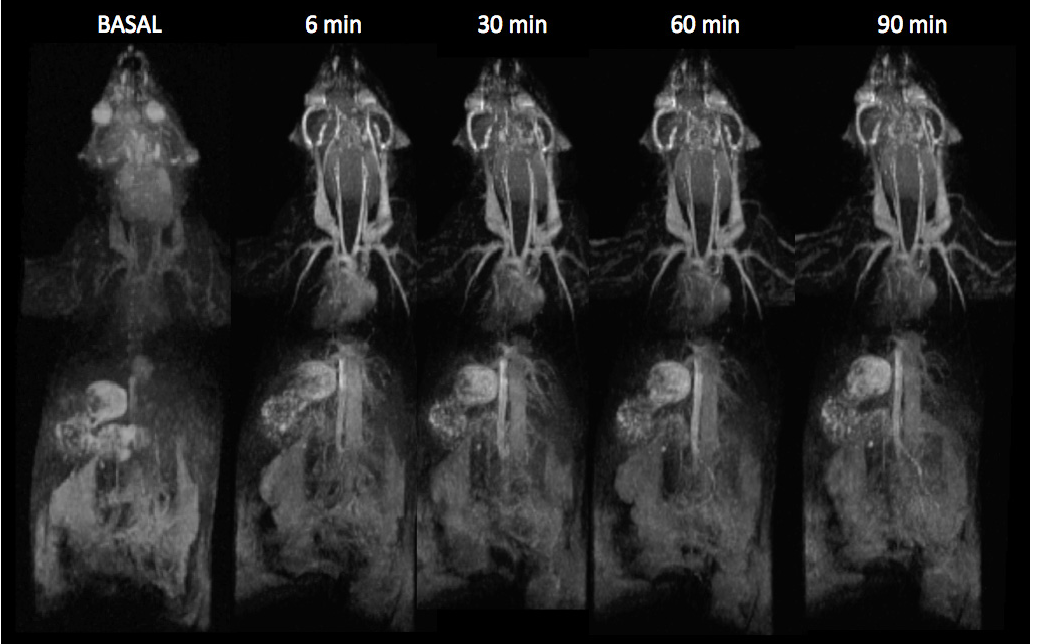
Figure 3. Magnetic resonance angiography of a mouse at increasing times after intravenous injection of